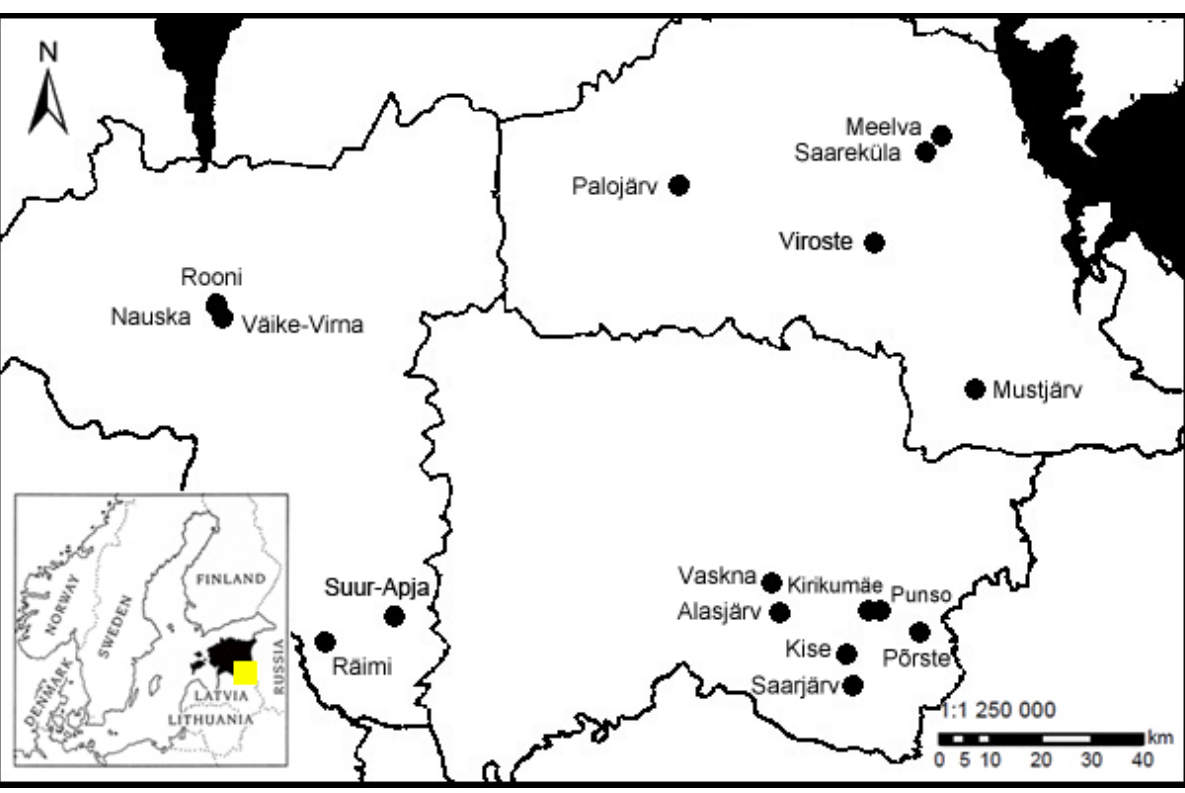
Figure 1. Locations of the selected lakes around which quagmires were